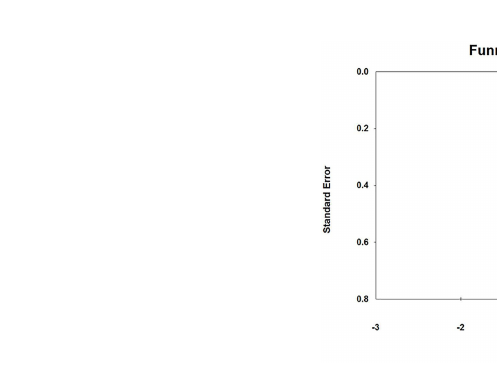
FIGURE 3 | Funnel plot of all included